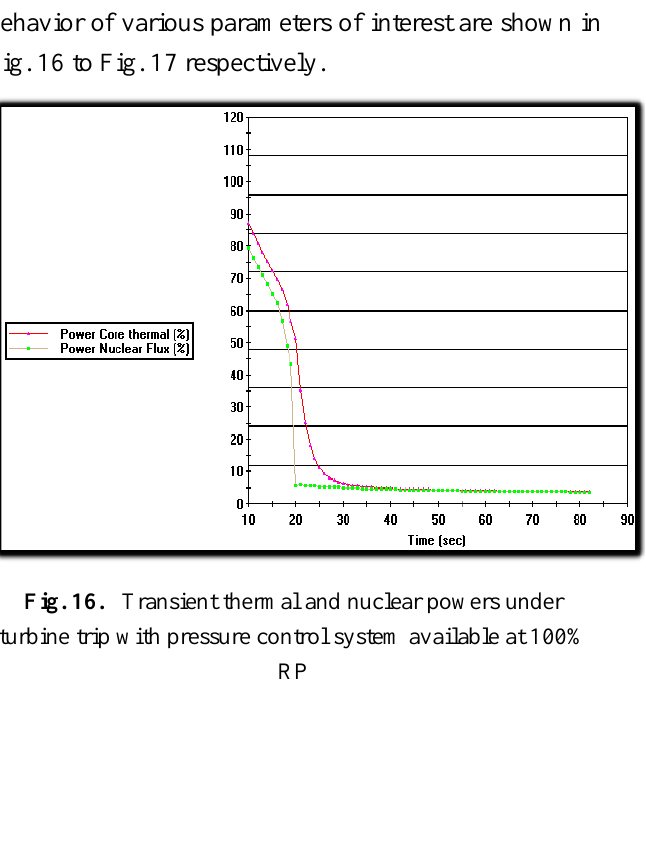
Fig. 17. Transient reactor coolant pressure under turbine trip with pressure control system available at 100% RP Upon turbine trip with pressure control system available, the reactor neutron flux and reactor thermal power closely tracks each other. The reactor coolant pressure initially increases 165.5 bar then decreases and Fig. 15. Transient feed-water and steam flows under reactor stabilizes to 155 bar pressure. The cold leg, hot and trip at 100% RP average temperatures drops from their steady values to 135.5  C. Rest of the all plant parameters are also found well within the design and safe limits.